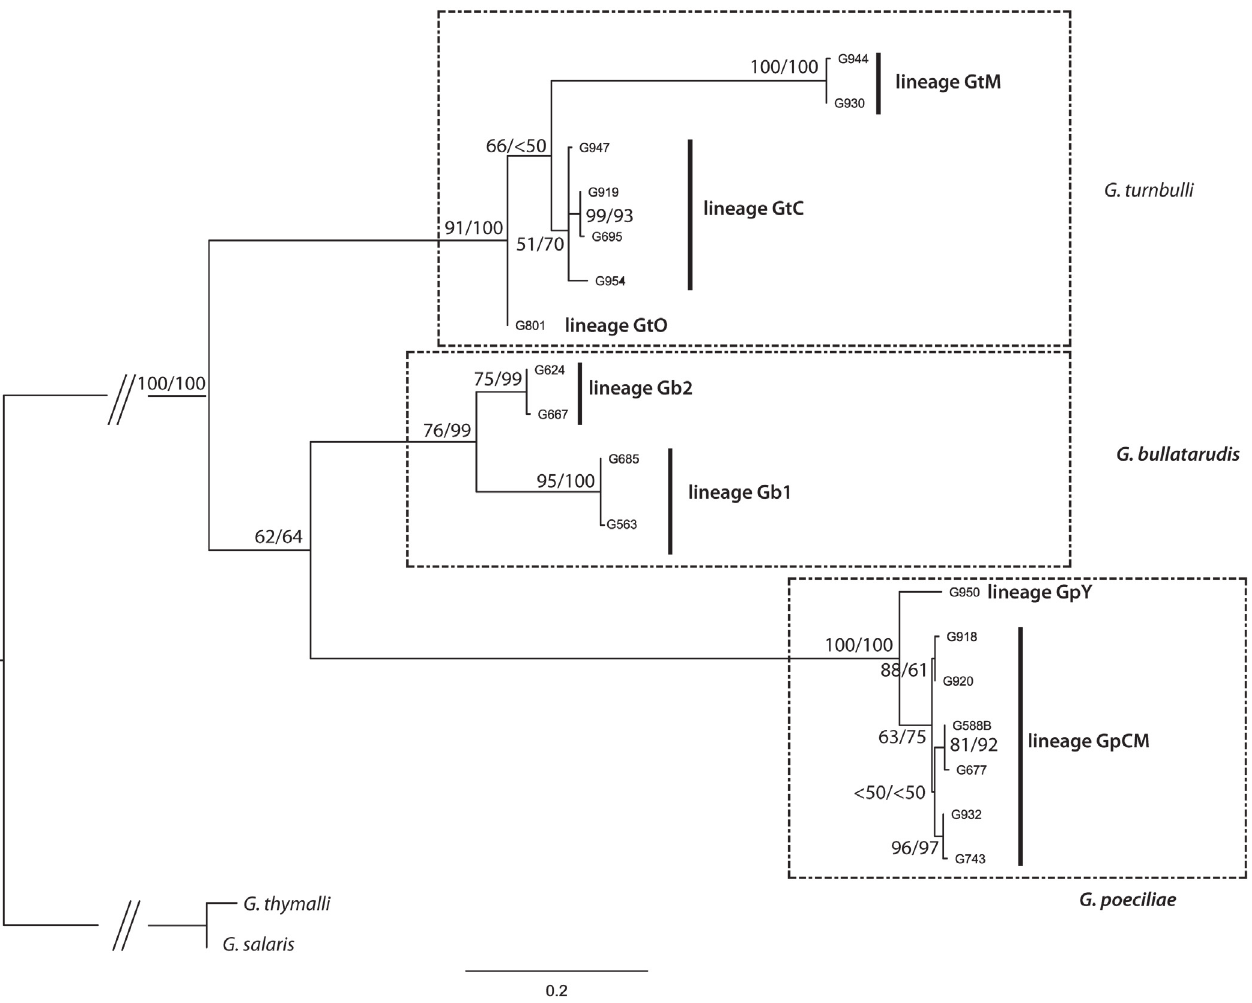
Figure 2. Best Maximum-likelihood tree obtained for the COII of the three Gyrodactylus study species. Values of nodes correspond to bootstrap support and Bayesian posterior probability, respectively. The three major clades corresponding to Gyrodactylus morphospecies are surrounded by a dotted line. Cryptic lineages within these clades are signaled with black